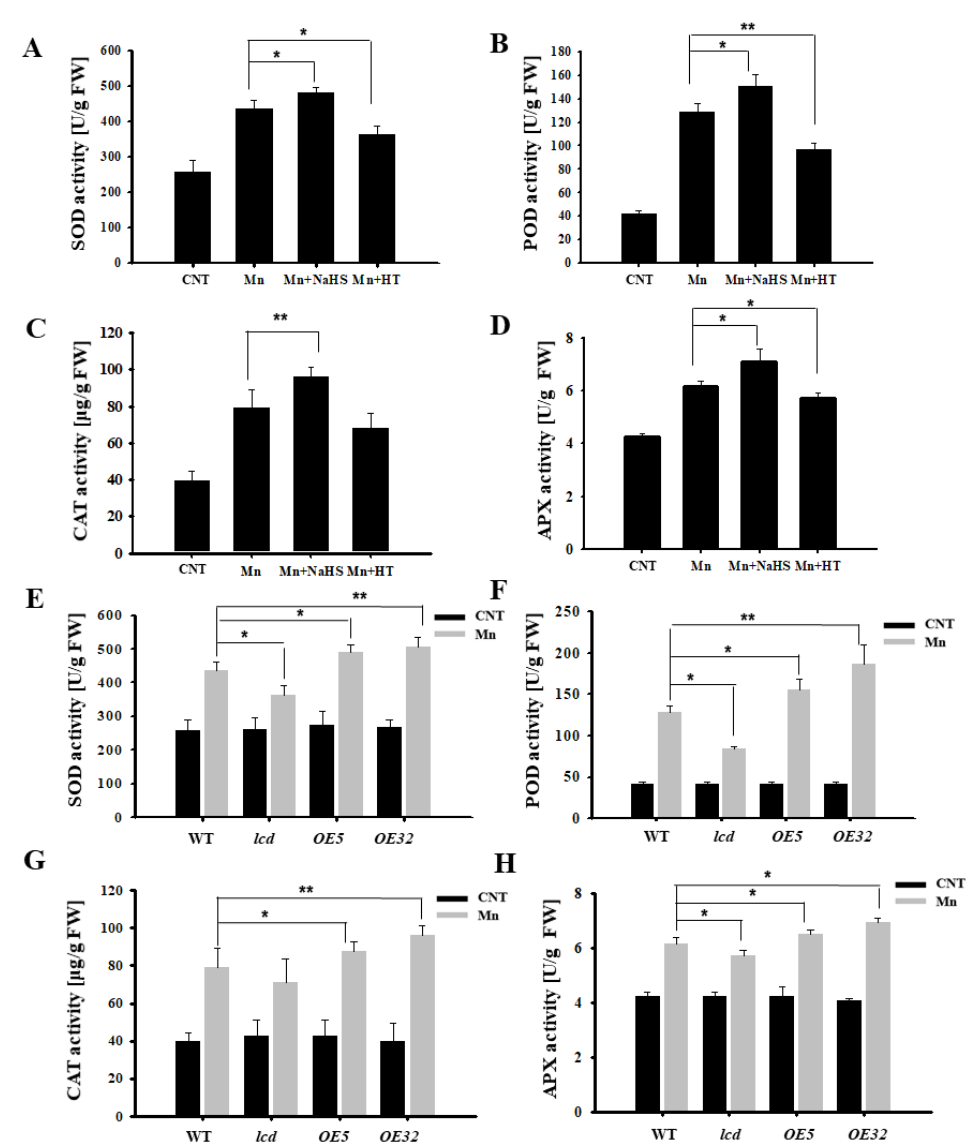
Figure 6. Effects of H 2 S on antioxidant enzyme activities in Arabidopsis seedlings under Mn stress. Effects of NaHS and HT on the activity of SOD ( A ), POD ( B ), CAT ( C ), and APX ( D ) in wild-type Arabidopsis seedlings under Mn stress. The activity of SOD ( E ), POD ( F ), CAT ( G ), and APX ( H ) in wild type, lcd , and two independent overexpression line seedlings treated with and without manganese. Three independent experimental replications were conducted. Values are the means ± SE of three independent experiments (* p < 0.05; ** p < 0.01).